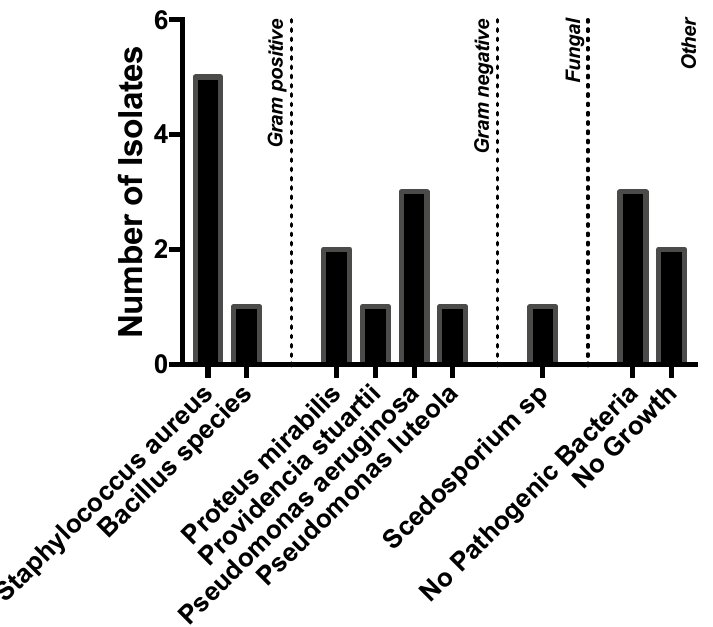
Figure 2. Number of positive swabs. Number of isolates of organisms obtained by culture of purulent drainage in patients with CSOM.